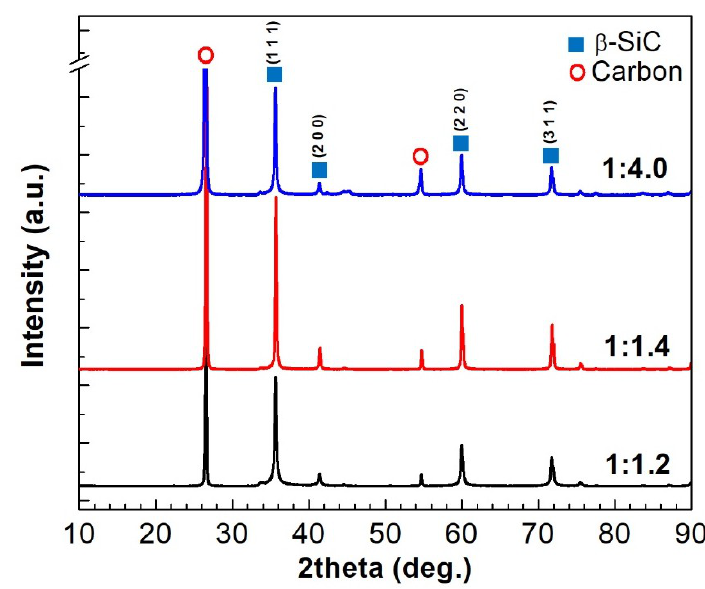
Figure 5. XRD patterns of the products after SiC synthesis treatments.